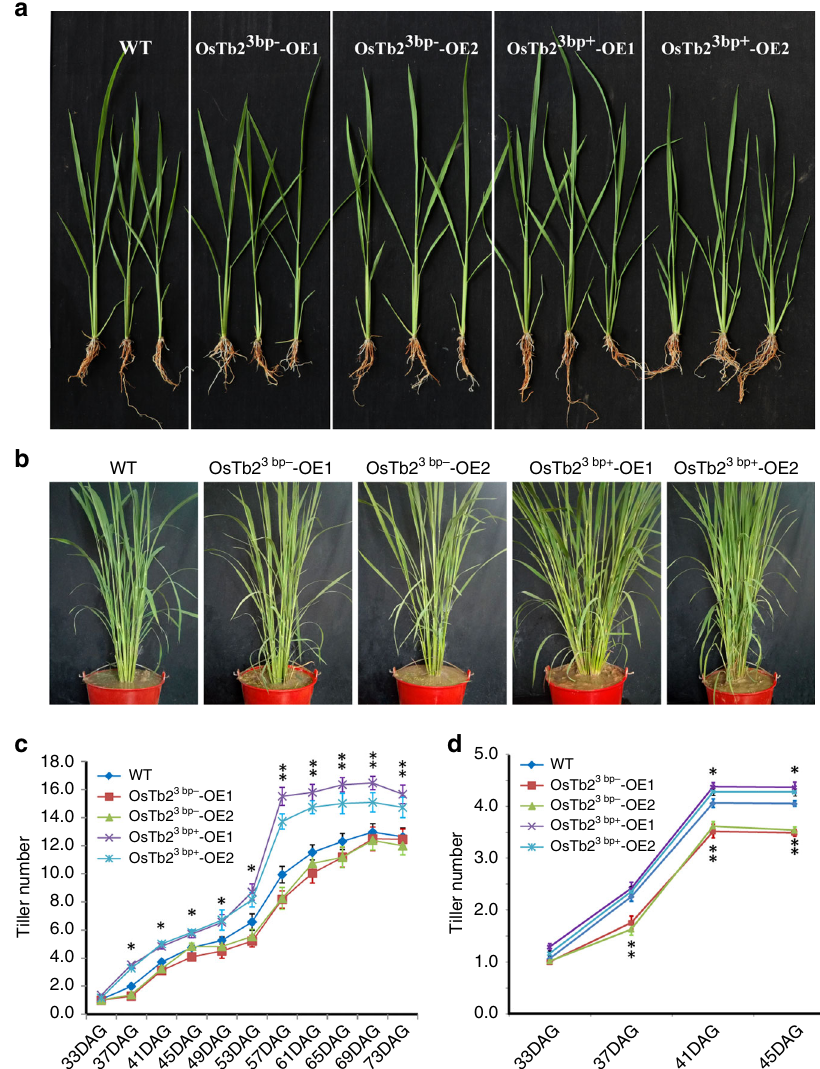
Fig. 3 OsTb2 3bp + can positively regulate rice tillering. a Phenotypes of transgenic plants overexpressing two genotypes (3 bp + and 3bp-) of OsTb2 at 30 DAG under irrigated conditions. WT, wild type. b Phenotypes of transgenic plants overexpressing two genotypes of OsTb2 at 65 DAG under irrigated conditions. WT, wild type. c Tiller number of transgenic plants overexpressing both OsTb2 3bp + and OsTb2 3bp − at different DAG under irrigated conditions. d Tiller numbers of transgenic plants overexpressing both OsTb2 3bp + and OsTb2 3bp − at different DAT under dryland conditions. Each value in c, d represents the mean ± s.d. (n = 50 plants). Student ’ s t -test analysis indicated a signi fi cant difference (compared with the WT control, * P < 0.05, ** P <